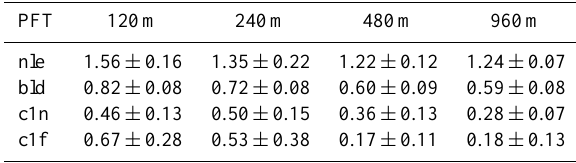
Table 4. Annual average Bowen ratio and standard deviation along the cross-section AA (cid:48) for the land-use classes nle (needleleaf ever- green tree), bld (broadleaf deciduous tree), c1n (crops with seasonal LAI), and c1f (crops with fixed